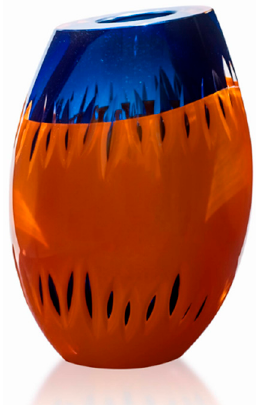
Figure 11. Bronholm# , Vítor Agostinho (glassblowers: Alfredo Poeiras e Cláudio Duarte) 2016. Photo credit: the designer.